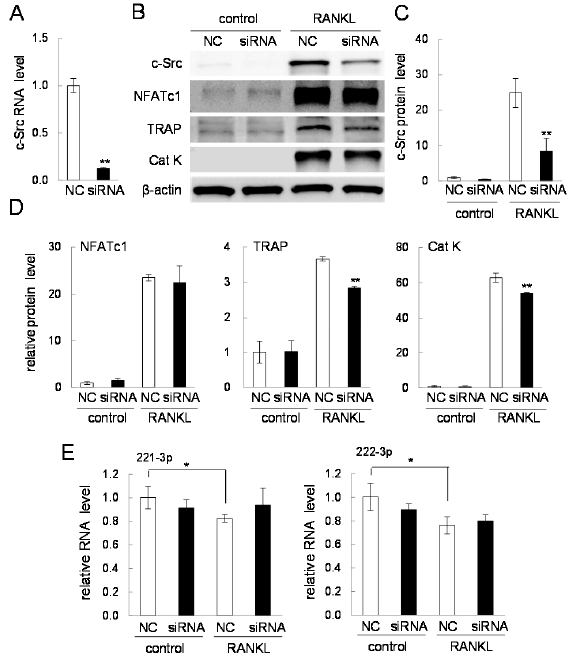
Figure 8. Effects of c-Src siRNA. Of note, 50 ng/mL RANKL was used for two days in ( B – E ). The sample number was three in all cases. NC = non-specific control siRNA. The single and double asterisks indicate p < 0.05 and p < 0.01, respectively. ( A ) c-Src mRNA levels in response to c-Src siRNA; ( B ) Western blot analysis of c-Src, NFATc1, TRAP, and cathepsin K in response to c-Src siRNA; ( C ) Quantified protein levels of c-Src in response to c-Src siRNA; ( D ) Quantified protein levels of NFATc1, TRAP and cathepsin K in response to c-Src siRNA; and ( E ) Levels of miR-221-3p and miR-222-3p in response to c-Src siRNA.